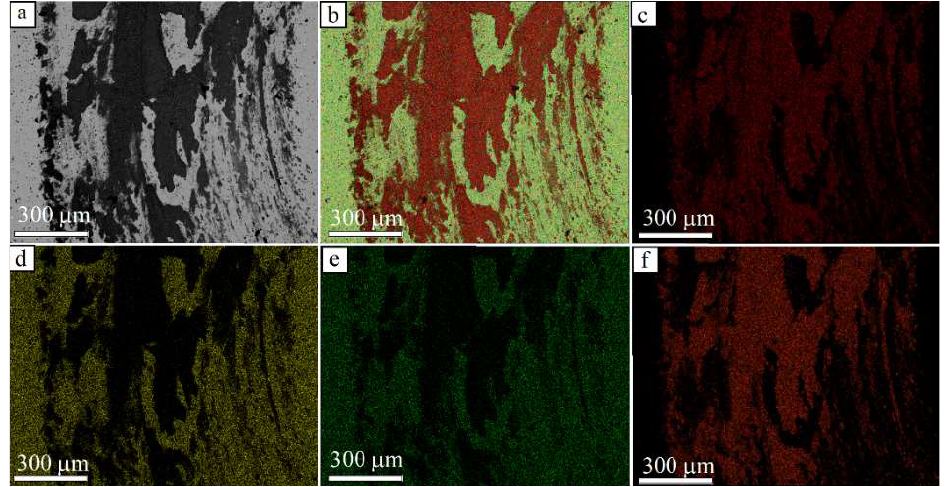
Figure 14. SEM image ( a ) and EDS element distribution maps for all elements ( b ), O ( c ), Zr ( d ), Cr ( e ) and Fe ( f ) obtained from the worn surface of the ZrCrN(5) coating after sliding at 6N.